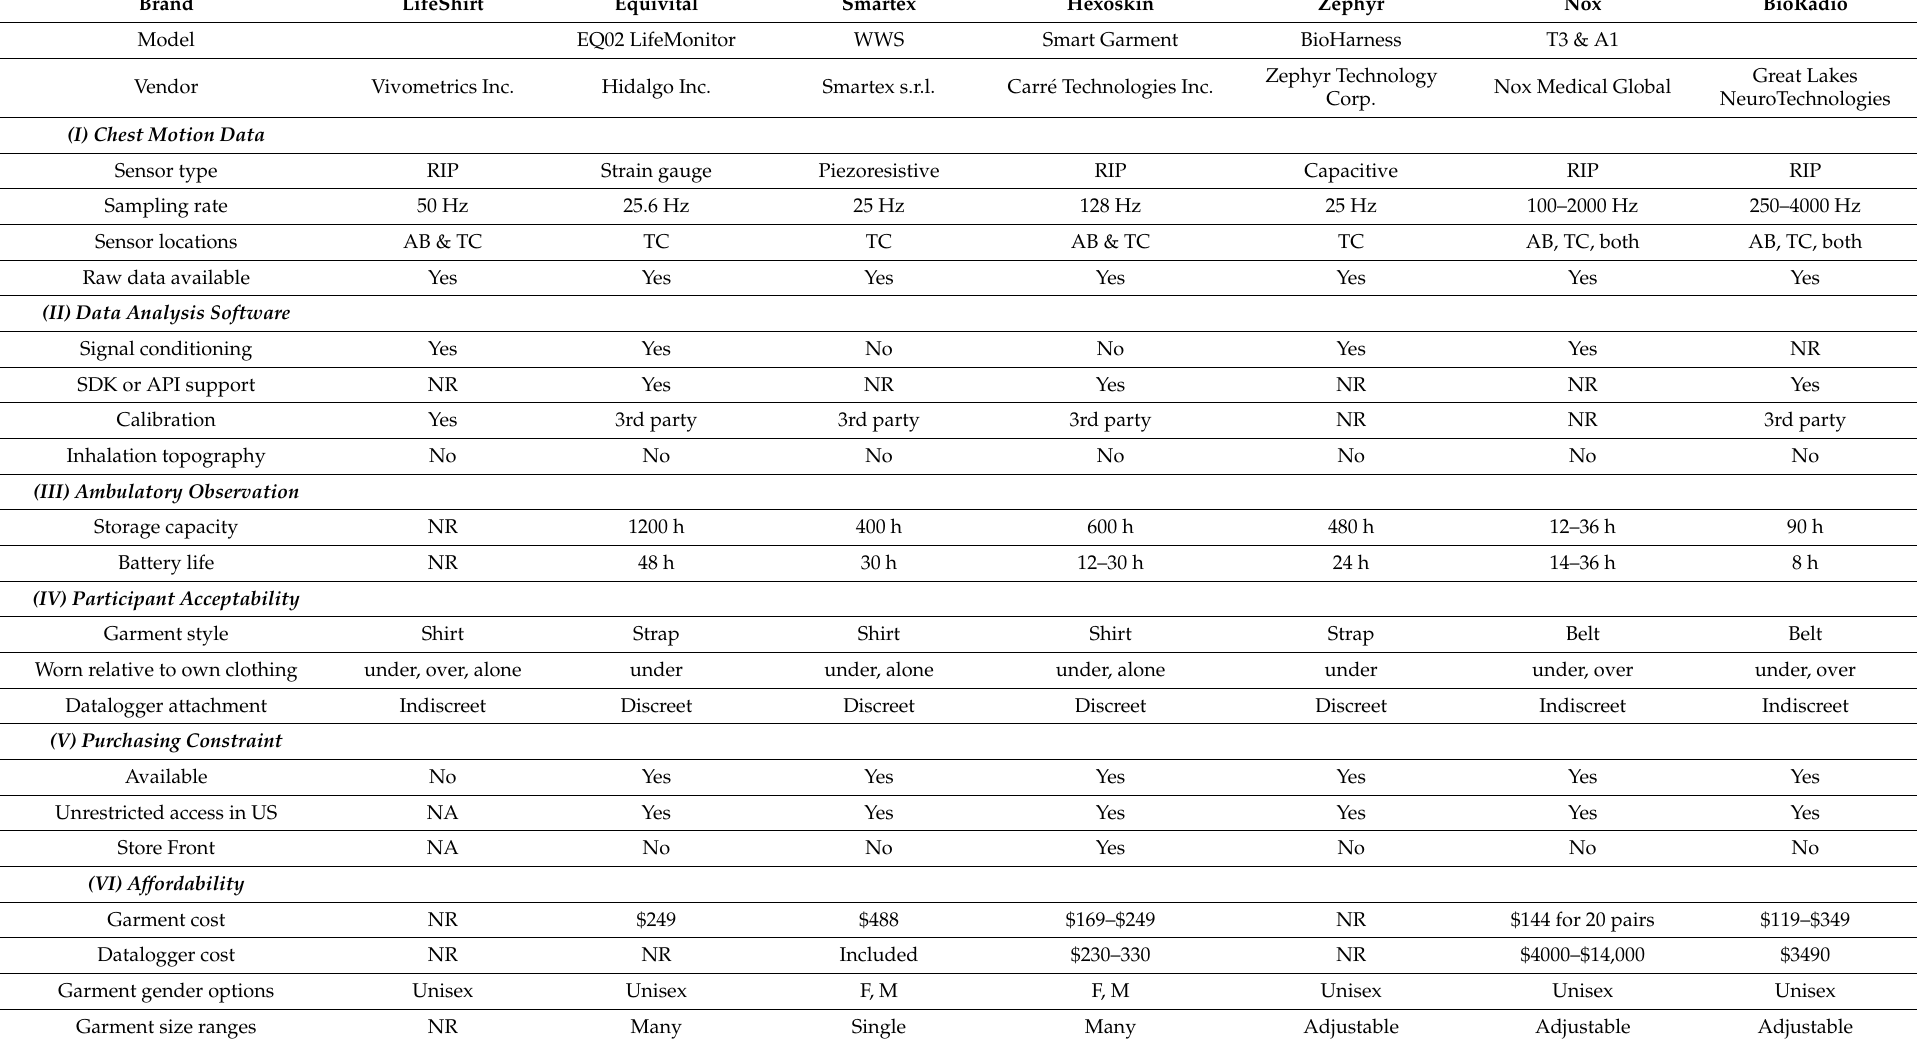
Table 2. Product characteristics grouped by assessment attributes for each Wearable Respiratory Monitor. NA = Not Applicable, NR = Not